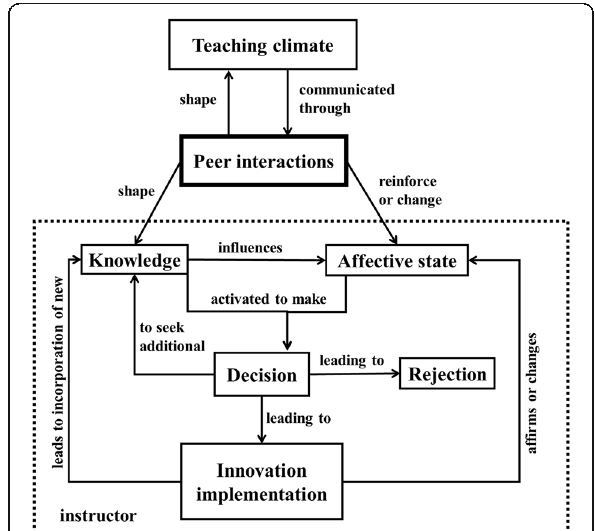
Fig. 1 A model of peer effects on instructor innovation